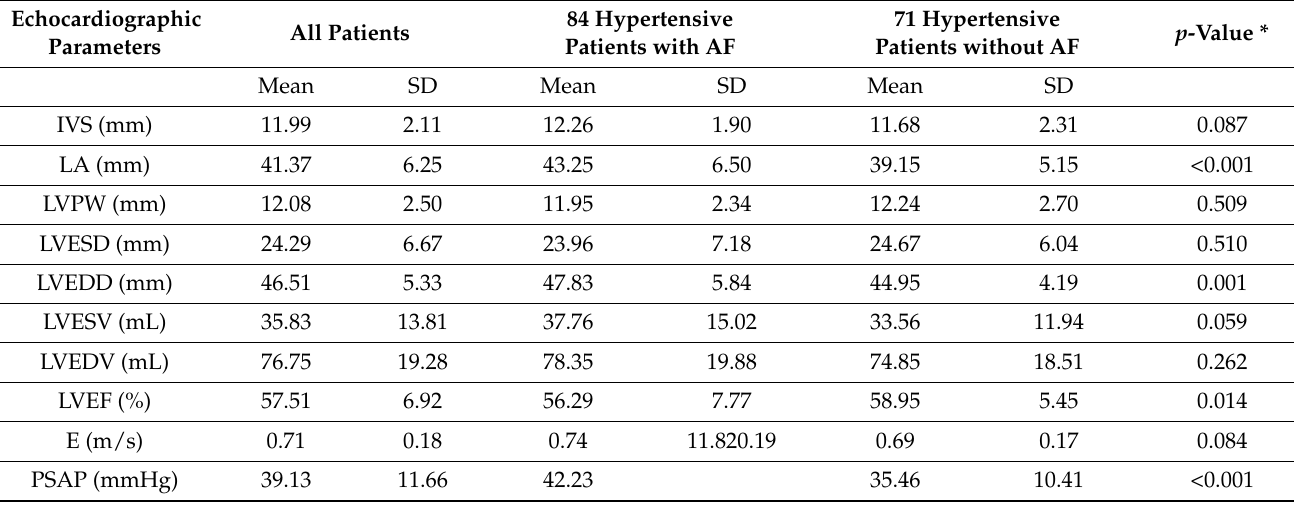
Table 4. Echocardiographic parameters of left ventricle systolic function in both groups of patients. Assessment of diastolic transmitral flow and LV systolic function using pulsed wave Tissue Doppler Imaging at the lateral mitral annulus.